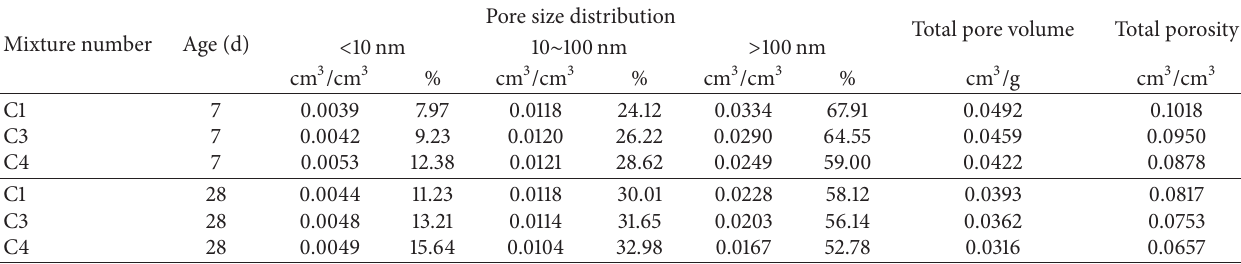
Figure 7: Scanning micrographs of cementitious materials: (a) 7 days × 100, (b) 7 days × 5000, (c) 28 days × 200, and (d) 28 days × 5000. Table 4: Pore size distribution of the cementitious